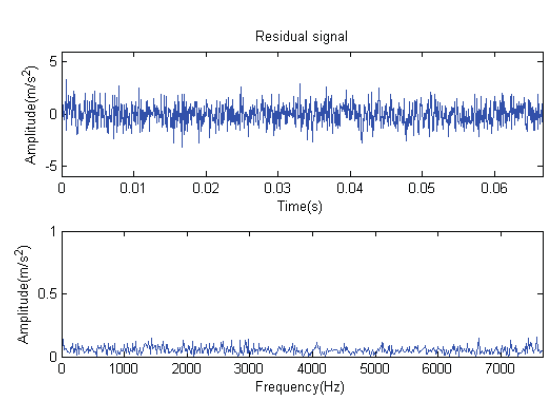
Figure 27. Residual signal.